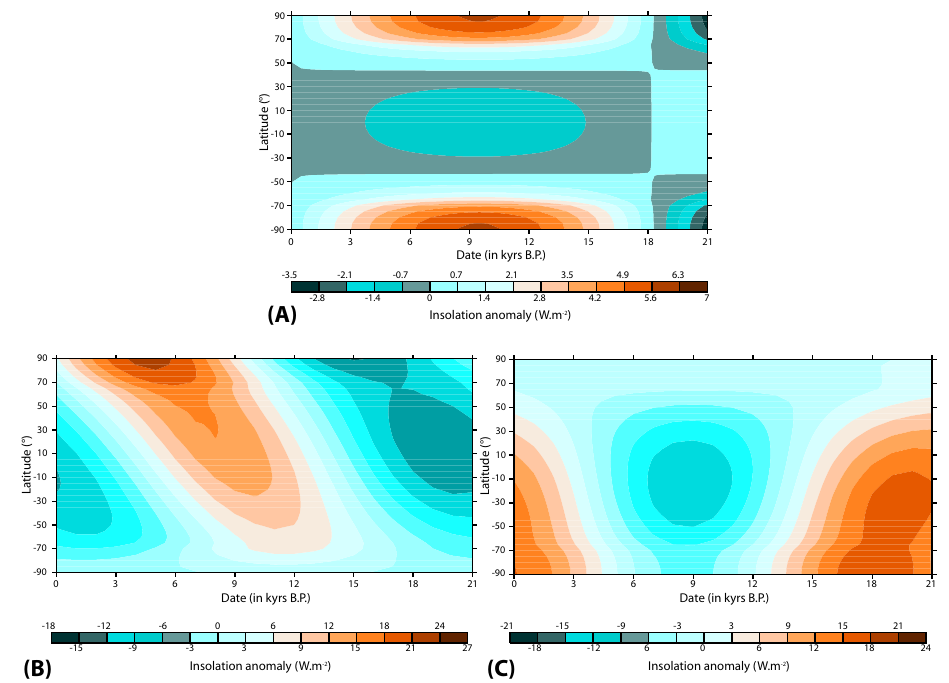
Fig. 2. Insolation anomaly to the 0–30kyrs BP mean for the last deglaciation computed from Berger (1978) for (A) the annual mean, (B) the northern summer, (C) the northern winter. For (B) and (C) the summer (winter) is computed as the second (fourth) quarter of year after the spring equinox.